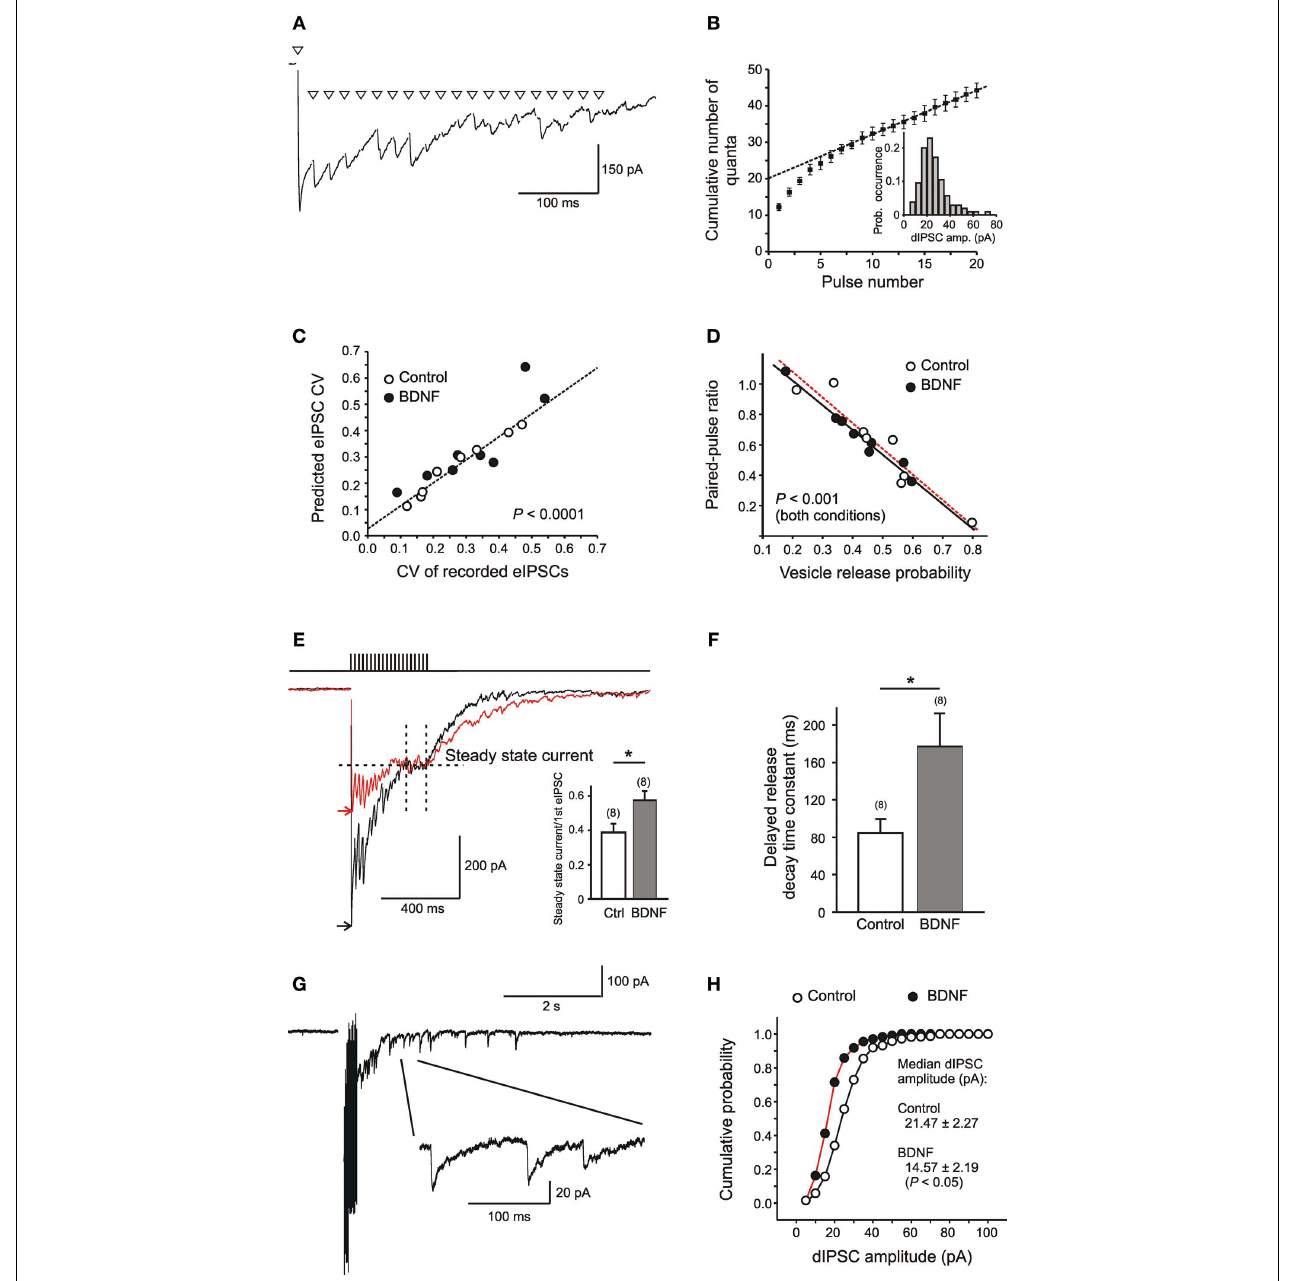
FIGURE 3 | Measurement of RRP, p ves , and Q in collicular neurons, and the effects of BDNF. (A) Specimen trace of eIPSCs induced by high-frequency (HF) stimulation (20 pulses at 50Hz) of a single GABAergic axon. For clarity stimulus artifacts are replaced by triangles. (B) Cumulative plot of eIPSC amplitudes vs. stimulus number.The eIPSC amplitudes were normalized to the median dIPSC amplitude of the same unitary connection (inset). Back-extrapolation to the y intercept indicates RRP. (C,D) Tests for applicability of the estimates of p ves . (E) Sample records to illustrate BDNF effects on IPSCs induced by HF stimulation.To obtain the amplitude of the steady state current, the current integral was normalized to the total time of integration for the last five stimulus intervals. Arrow heads denote the peak